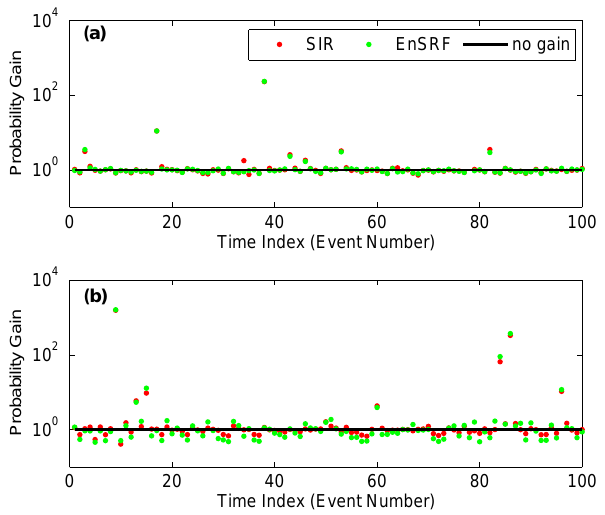
Fig. 5. Probability gains of the SIR particle filter and the EnSRF over the benchmark for each individual earthquake for the case of (a) uniformly distributed and (b) Gaussian mixture distributed ob- servational errors. In (a) , the gains of the SIR and EnSRF are often nearly identical.